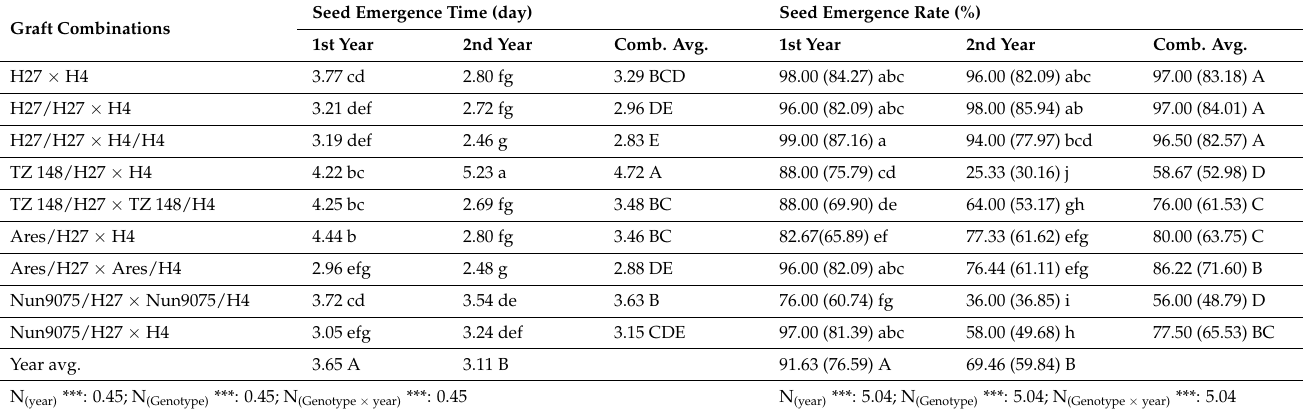
Table 9. Seed emergence time and emergence rate of different graft combinations in both years.